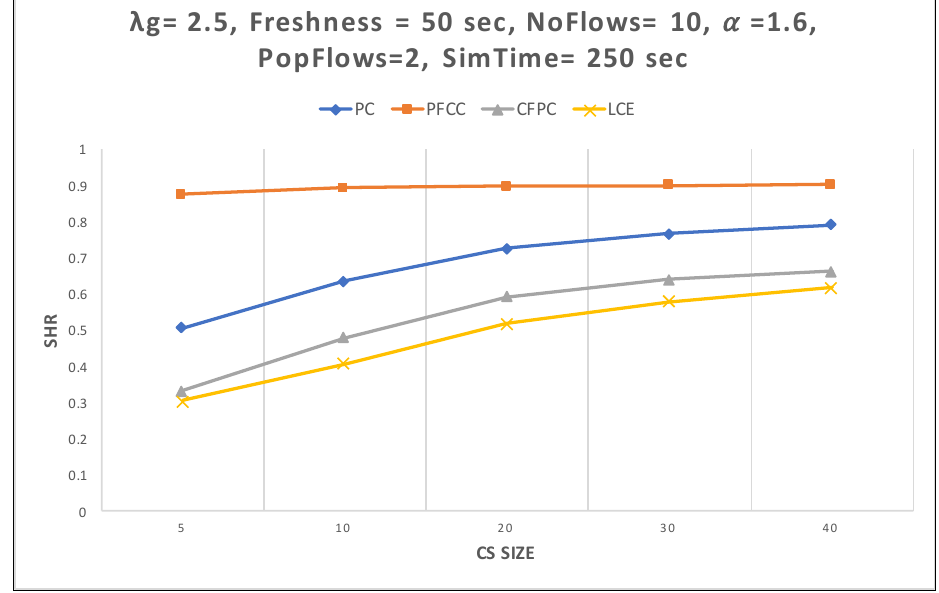
Figure 11. Server hit reduction ratio for popular traffic as a function of CS